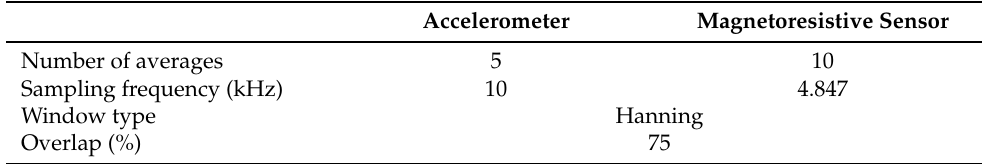
Table 3. Parameters for vibration